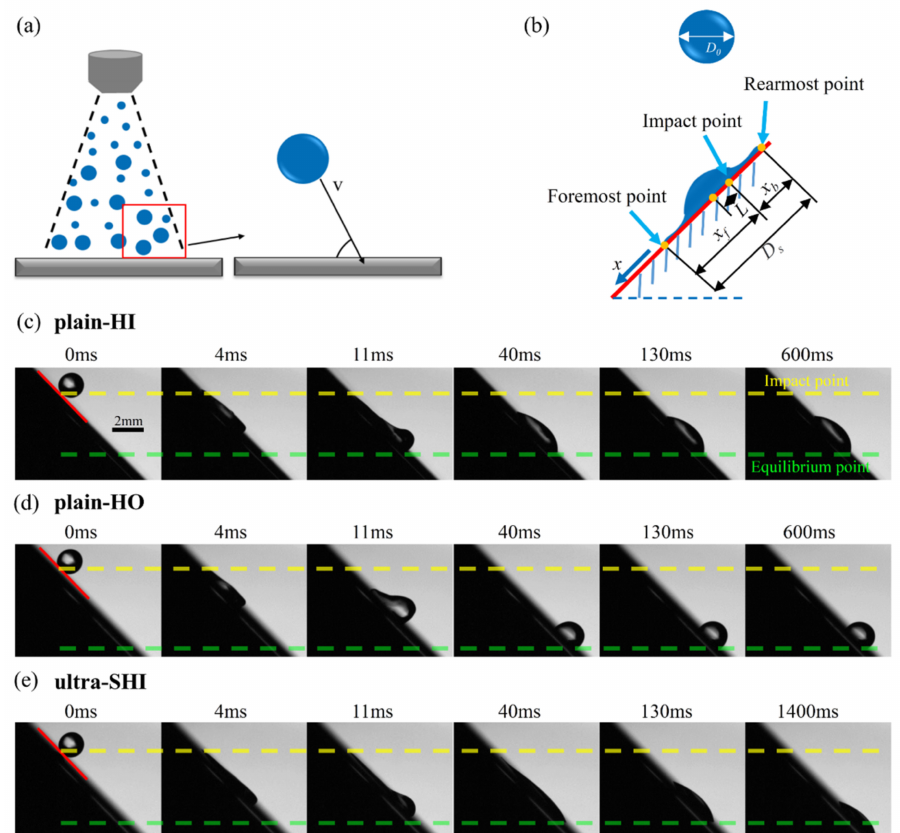
Figure 7. Droplet spreading and slipping dynamics on inclined surfaces with different surface wettability values. ( a ) Schematic of the droplet impact on the surface at different angles. ( b ) Analysis of the droplet impact on an inclined surface. Spreading dynamics of the droplet impact on inclined surfaces, including the ( c ) plain-HI surface, ( d ) plain-HO surface, and ( e ) ultra-SHI surface. We = 28.71. The inclination angle of the surface is 45 ◦